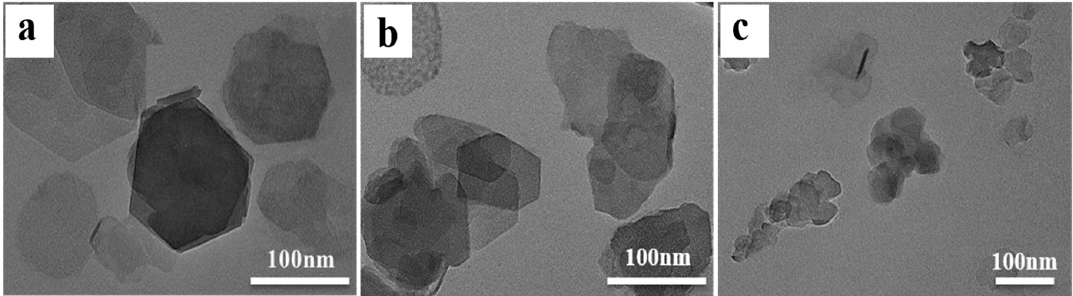
Figure 2. TEM micrographs of LiAl-LDHs at varied initial Li + concentrations ( a ) 6.75 g/L, ( b ) 3.375 g/L, ( c ) 1.6875 g/L.